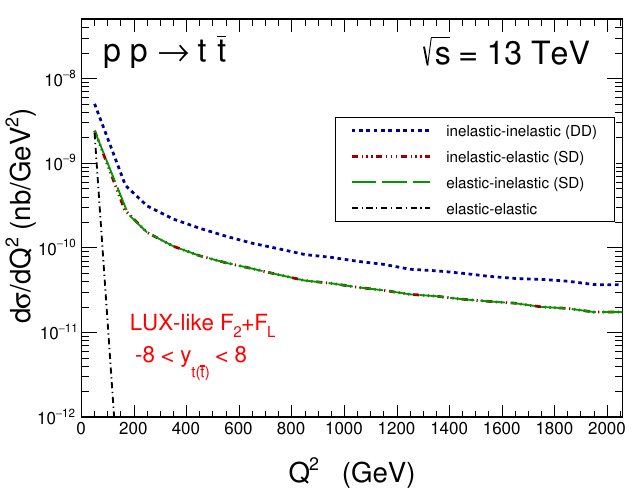
Figure 6 . Photon virtuality distribution for di(cid:11)erent components de(cid:12)ned in the (cid:12)gure.